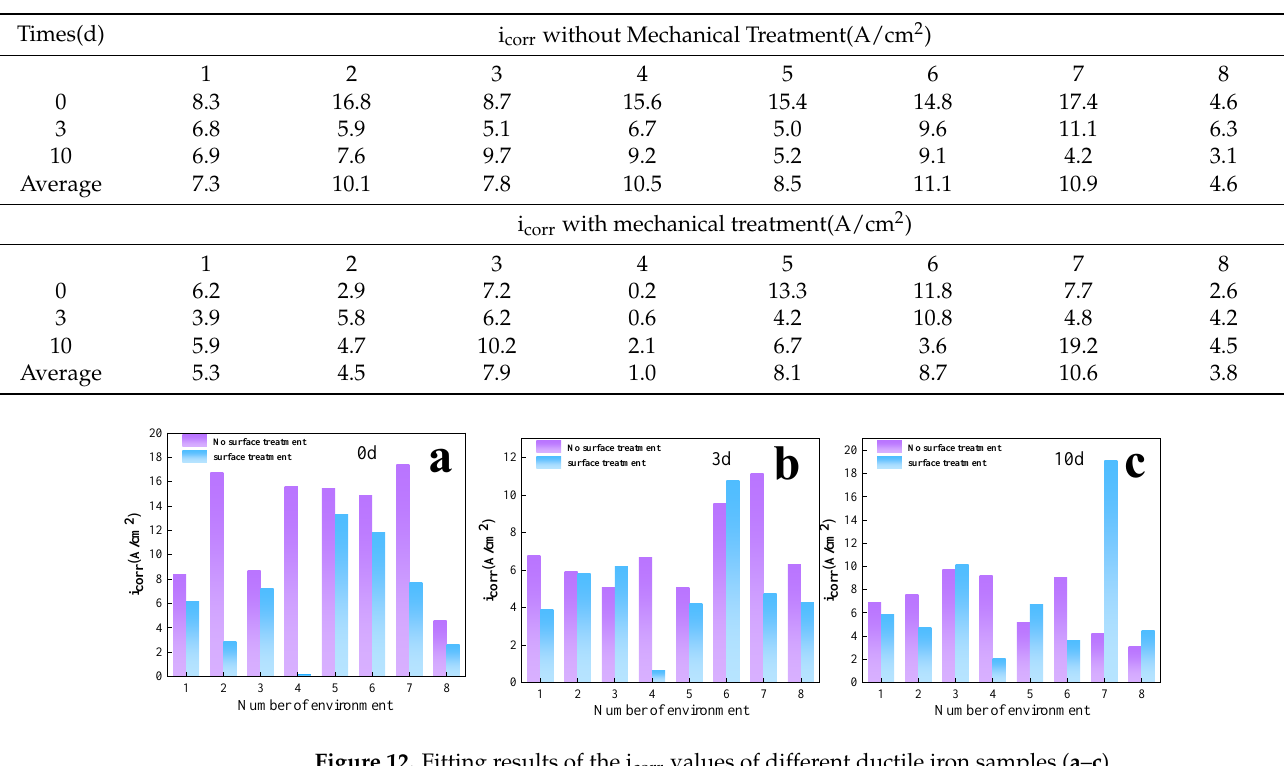
Figure 12. Fitting results of the i corr values of different ductile iron samples ( a – c ). Table 2. Fitting results of i corr by potentiodynamic linear polarization scanning.